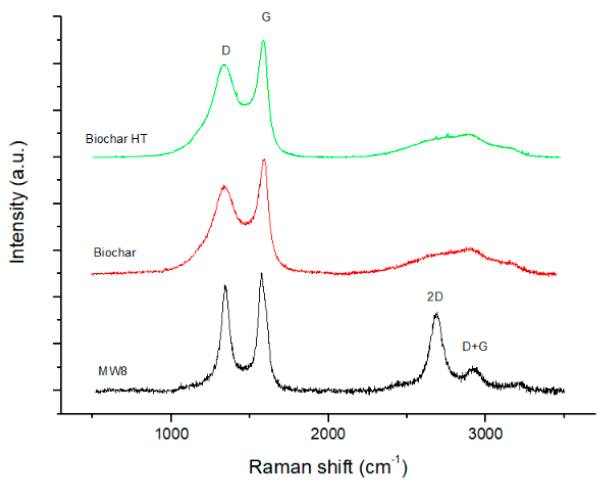
Figure 4. Raman spectra of MWCNTs (Multi-Walled Carbon Nano Tubes), biochar and biochar HT.